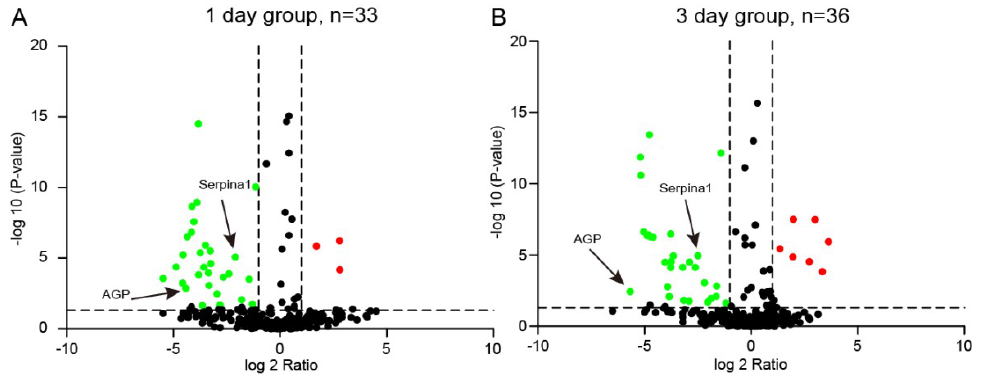
Figure 5. Volcano plot. Red dots indicate represent proteins significantly up-regulated in plasma samples of the injury group, while green dots indicate represent proteins significantly down-regulated in plasma samples of the injury group. Int. J. Mol. Sci. 2018 , 19 , x FOR PEER REVIEW